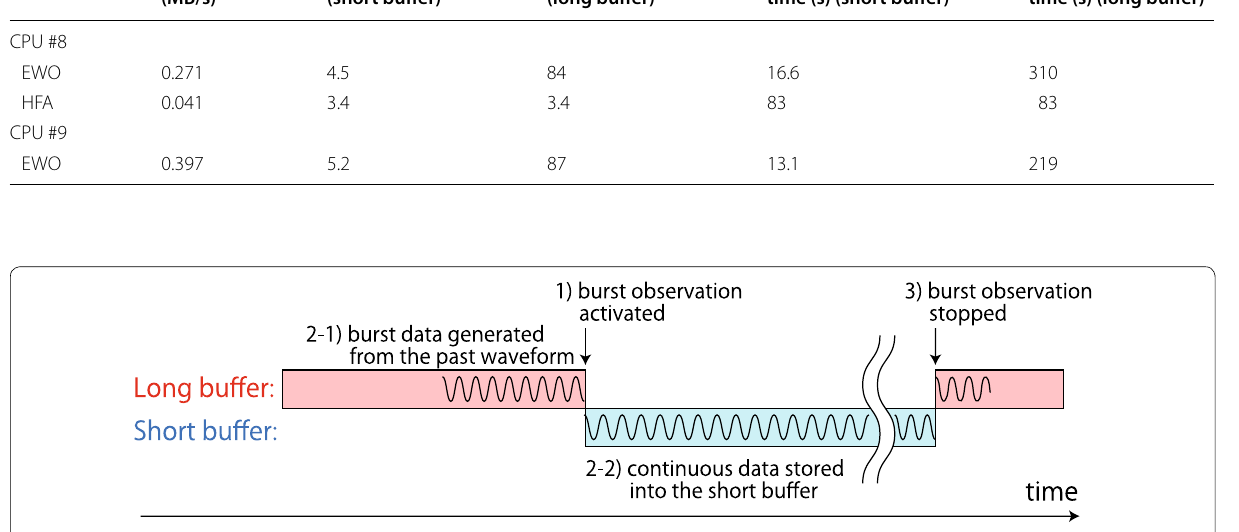
Fig. 2 Behavior of the signal buffers when a burst operation is